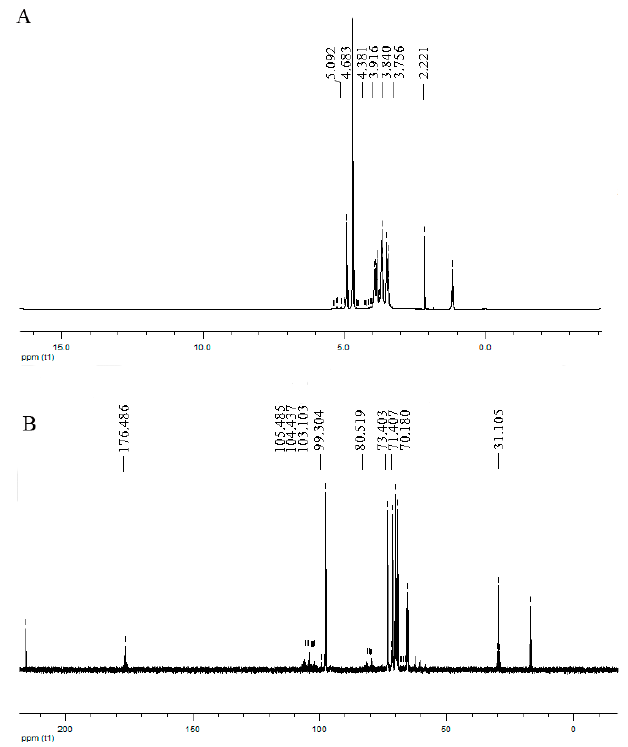
Figure 2. 1 H ( A ) and 13 C ( B ) nuclear magnetic resonance (NMR) spectra of HP.